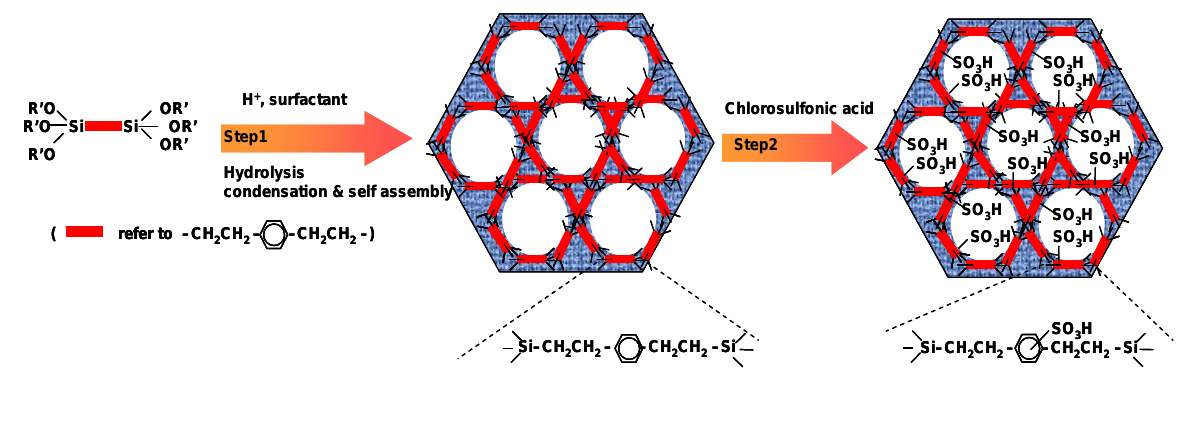
Figure 11. Schematic illustration of sulfonation process of the two step method. Reproduced with permission from Elsevier